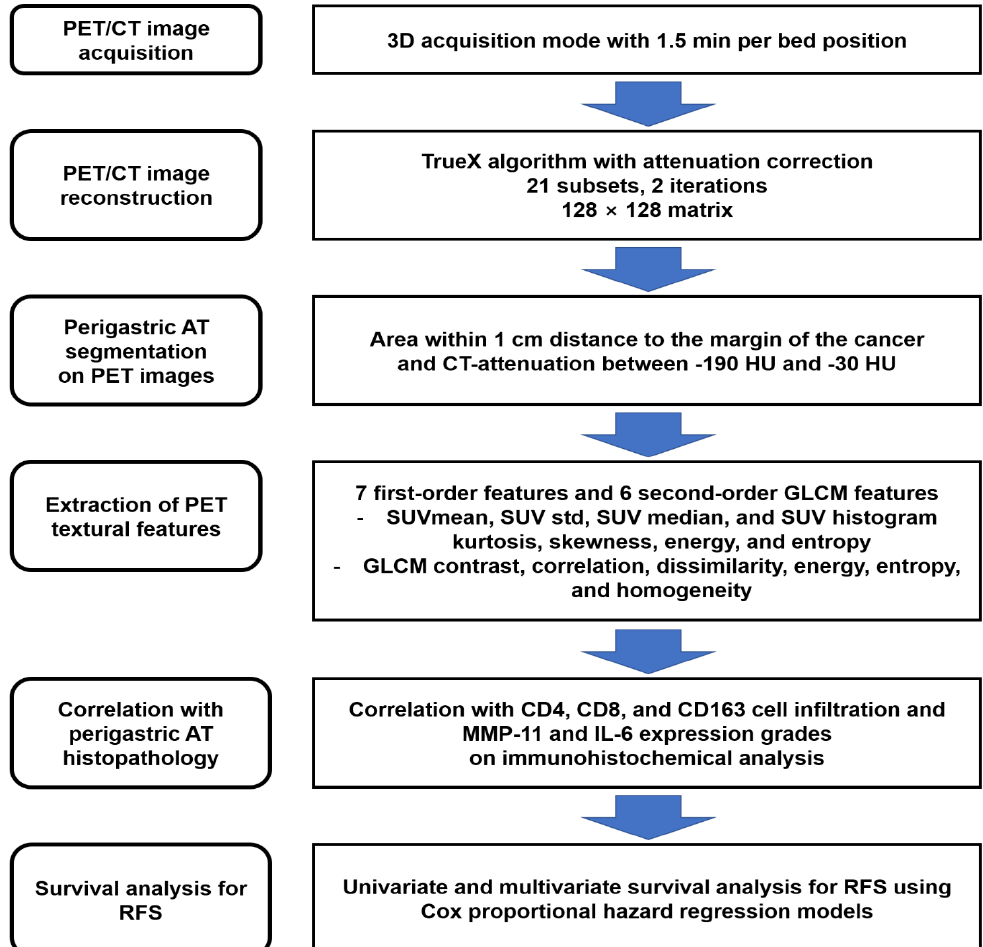
Figure 4. Schematic flowchart of the overall workflow.